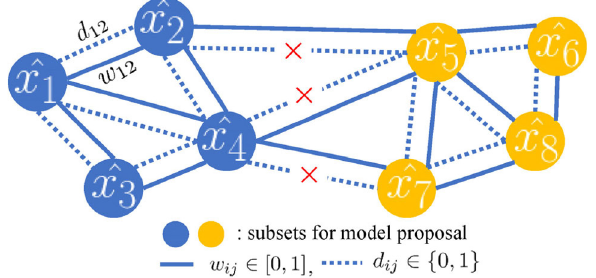
Fig. 2 Proposal sampling graph. Vertices represent WA data points ˆ x i . They are divided into two independent subsets (blue/yellow), according to the connectivity of dotted edges d ij . { d ij } are binary “bonds” in a random cluster model. Here, d 25 ,d 45 ,d 47 have weights of zero and others have weights of one. w ij denotes the edge probability between i -th and j -th vertices, used to probabilistically determine the values of { d ij } . Clusters induced by { d ij } form model